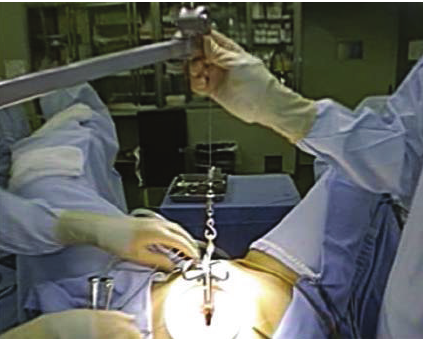
Figure 3: Gasless laparoendoscopic single-site myomectomy was performed through an Alexis wound retractor (small size, Applied Medical, Rancho Santa Margarita, CA) attached via a 2.5 cm midline umbilicalskinincisionwiththesurgicalviewsecuredbyabdominal- wall lifting with an intra-abdominal fan retractor system (Mizuho Co., Tokyo, Japan).